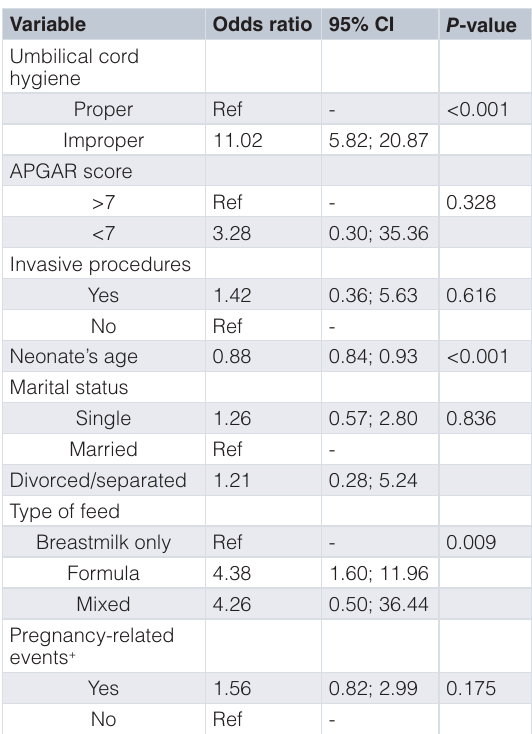
Table 6. Multivariable analysis for association between umbilical cord hygiene and qualifying covariates with neonatal sepsis among neonates at KHC, Kenya,